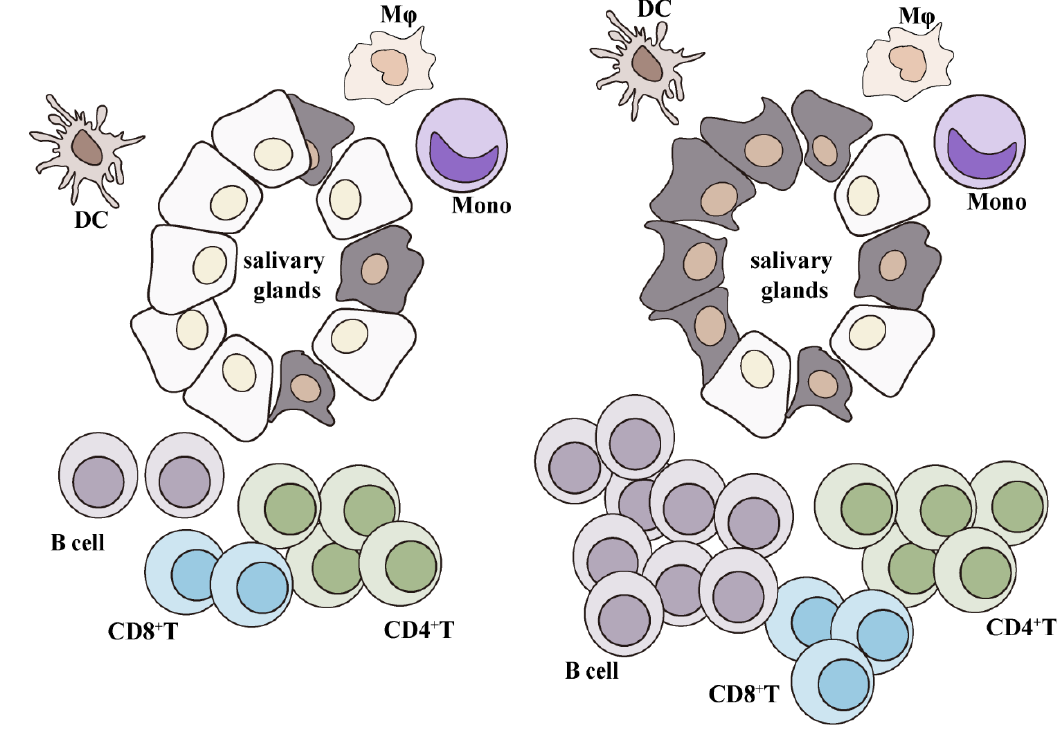
Figure 2. Graphics of immunocyte infiltration during the pathogenesis of SjS. At an early stage, the majority of infiltrated immunocytes in SGs of SjS patients are T cells ( left ), while, at a later stage, the prominent infiltrated immunocytes are B cells ( right ).